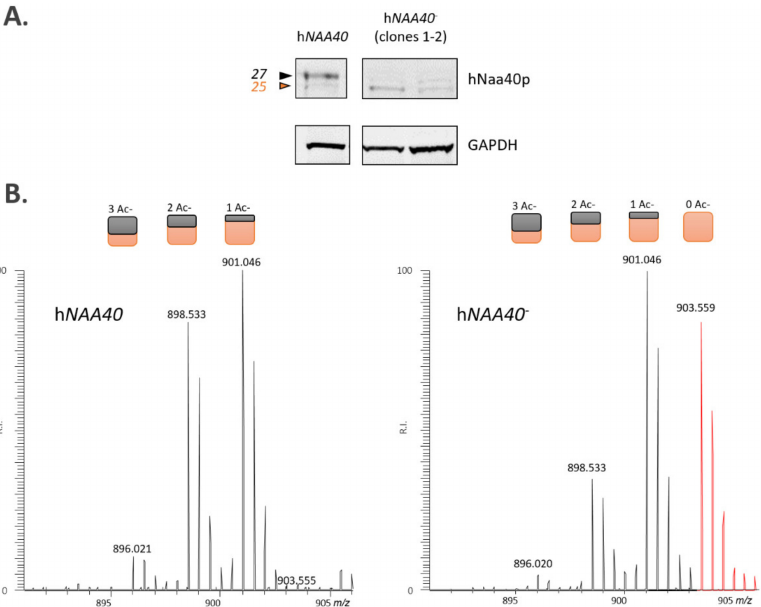
Figure 5. Residual hNaa40 S proteoform expression in h NAA40 L- knockout HAP1 cells is deficient in maintaining Nt-acetylation of the hNaa40p substrate histone H4. ( A ) Western blotting analyses of corresponding HAP1 WT and h NAA40 L- knockout HAP1 cell lysates (originating from two independent h NAA40 knockout clones) immunoblotted with antibodies specific for hNaa40p and GAPDH are shown. ( B ) Besides the identification of various N -acetylated forms of the mature N- terminus of human histone H4 ( 2 SGRGKGGKGLGKGGAKR 18 ), the fully N -free form (red MS trace) was only demonstrated in the h NAA40 - setup as inferred from the doubly charged variant observed at a higher m /z (903.559). The 5 Da spacing between the distinct isotopic envelopes, corresponds with the gain/loss of an in vivo N-acetyl group (i.e., free amines were in vitro N -acetylated using 13 C 2 D 3 -NHS acetate; introducing a 5 Da heavier acetyl moiety to each free amine [29,30]). Colored rectangles indicate the number of in vivo (black) and in vitro (orange) acetyl groups present per detected isotopic